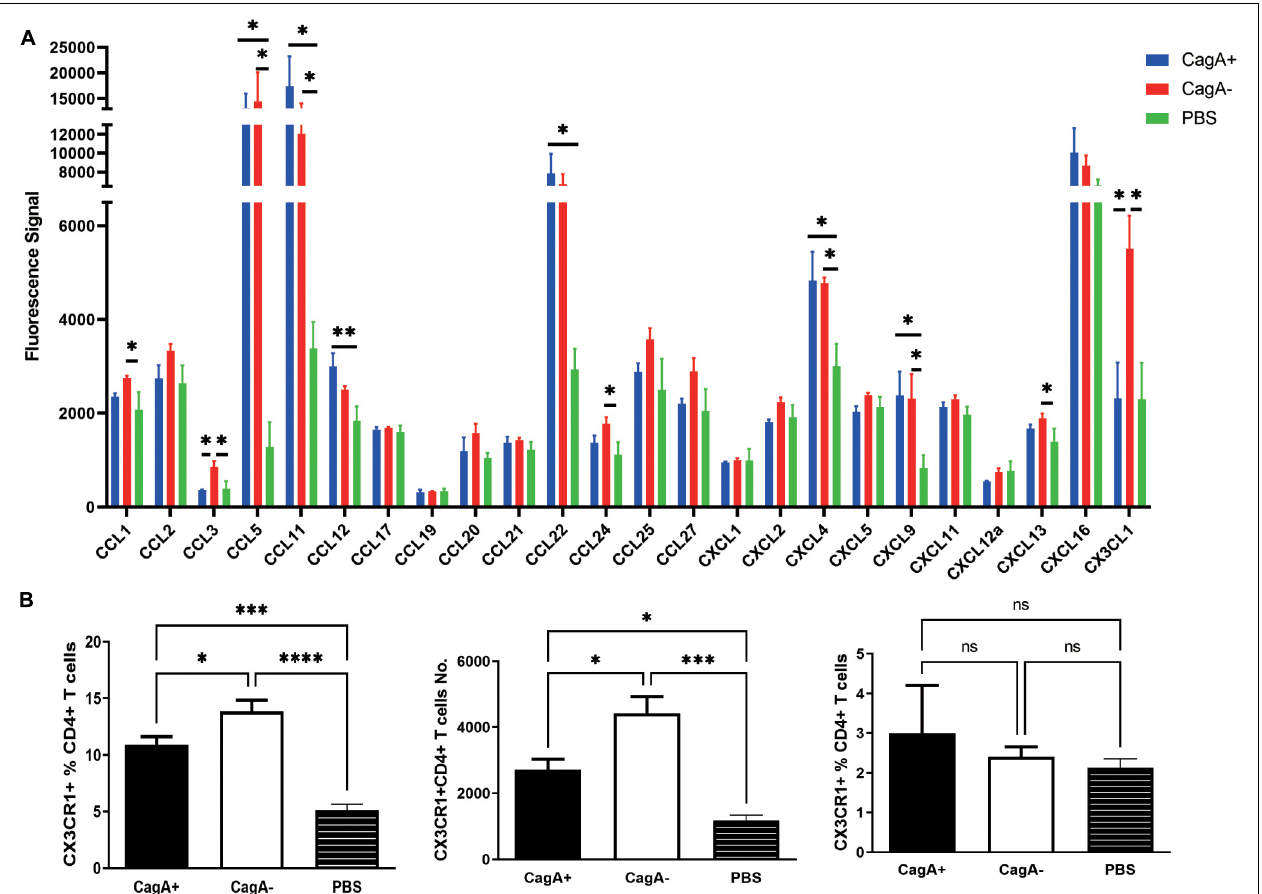
FIGURE 2 | Gastric chemokine CX3CL1 expression and the number of CX3CR1 + CD4 + T cells were significantly elevated in CagA − H. pylori -infected mice. Mice were infected with H. pylori strain NCTC11637 (CagA + ) or its isogenic mutant (cid:49) cagA NCTC11637 (CagA − ) via intragastric administration. Four weeks later, the stomachs and spleens were harvested. (A) A series of mouse mucosal chemokines were measured. (B) The percentage of CX3CR1 + cells in gastric mucosal CD4 + T cells and the number of CX3CR1 + CD4 + T cells were detected (left and middle). The percentage of splenic CX3CR1 + CD4 + T cells in CD4 + T cells is also shown (right). Data are shown as mean ± SD. N = 5, ∗ p < 0.05, ∗∗ p < 0.01, ∗∗∗ p < 0.001, and ∗∗∗∗ p < 0.0001. Data in (A) are representative of two similar experiments. Data in (B) are representative of three individual